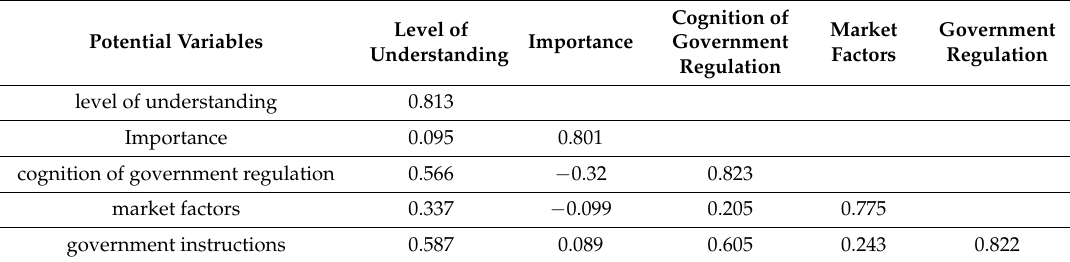
Table 5. Discriminant validity of latent